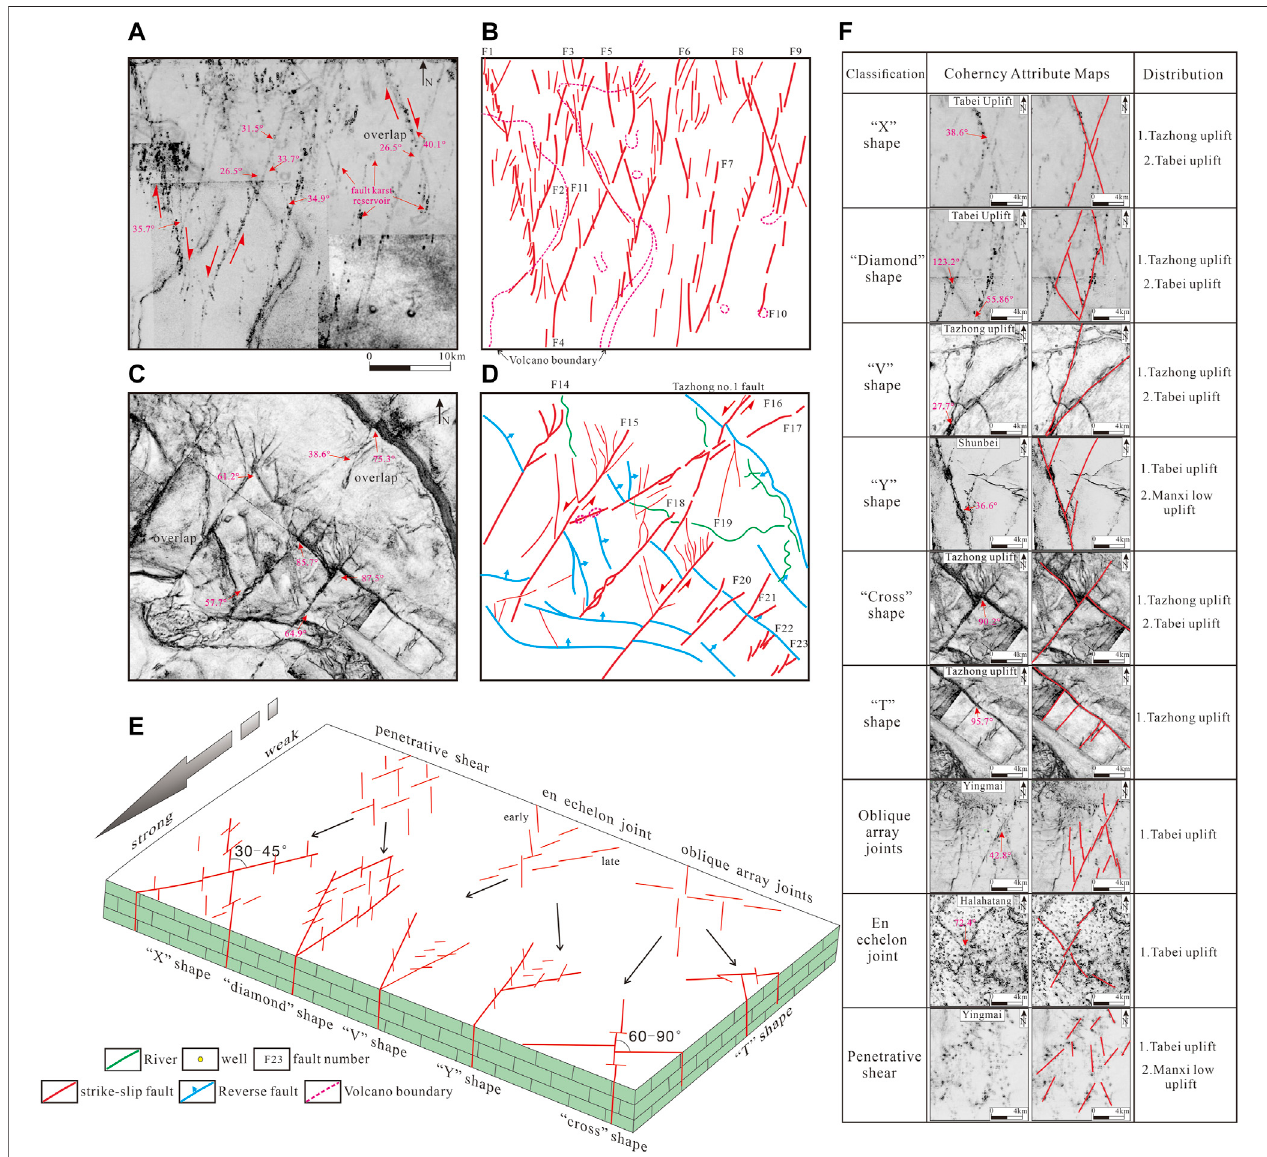
FIGURE 8 | Interpretations of strike-slip fault systems from 3D coherence cubes (To3, re fl ection surface; for location, see Figure 5 ): (A) 3D coherence cube slice from the Tabei uplift, (B) method of interpreting strike-slip fault systems for the Tabei uplift, (C) 3D coherence cube from the Tazhong uplift (for location, see Figure 5D , and (D) methodofinterpretingstrike-slipfaultsystemsfortheTazhonguplift. (E) Modelsofthestrike-slipfaultinmapview. (F) Criteriaforfault-typedeterminationusedin this study with the corresponding coherency attribute maps.